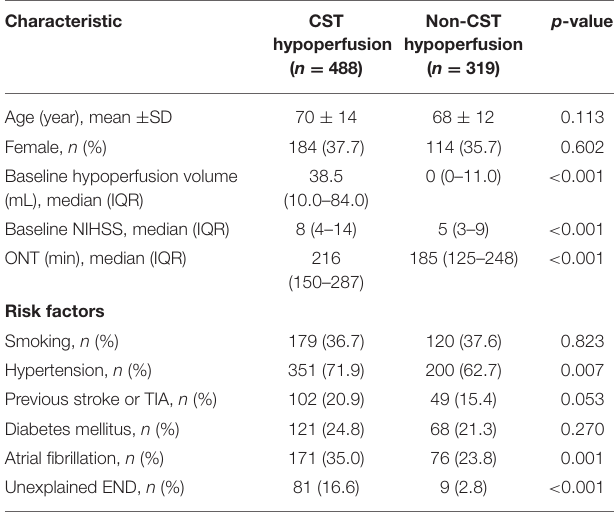
TABLE 1 | Comparison between unexplained early neurological deterioration (END) and non-unexplained END. Characteristic